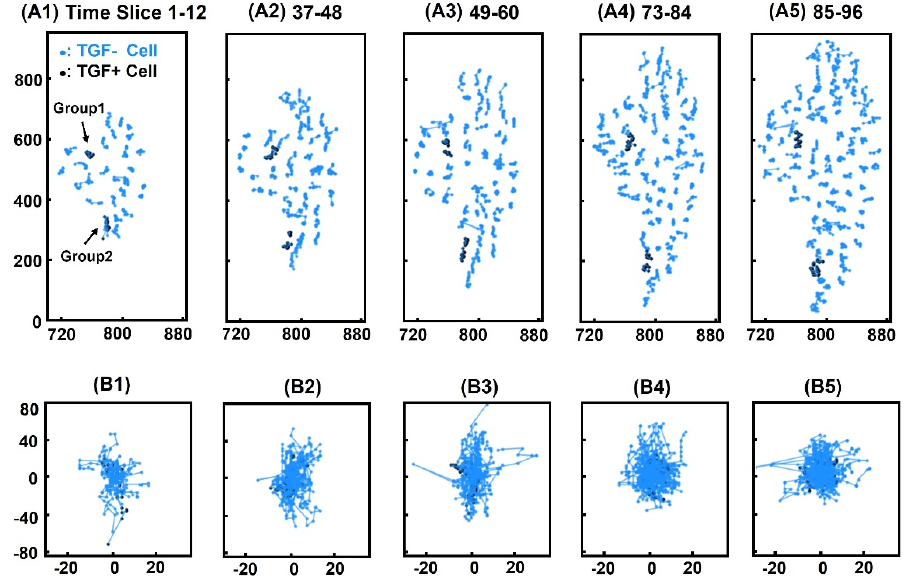
Figure 2. Before and after cell tracks’ positional normalization. ( A1 – A5 ) The positions of TGF (+) (black) and TGF ( − ) (blue) cells before normalization in different observation windows. ( B1 – B5 ) The positions after normalization, the initial position transferred to (0, 0).